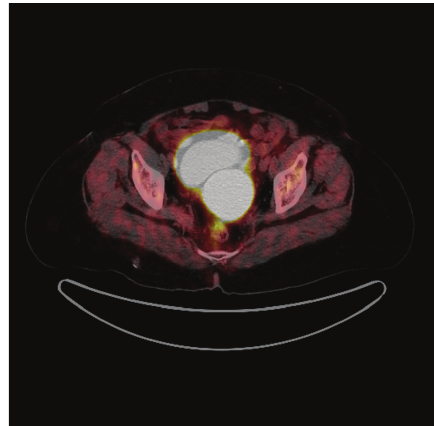
Figure 2: PET-CT demonstrates a mass of malignant melanoma in sizeof65 × 63 × 98 mmwiththeuptakeoffluoro-2-deoxy-D-glucose (FDG) (suv MAX 27.37) in uterine cervix